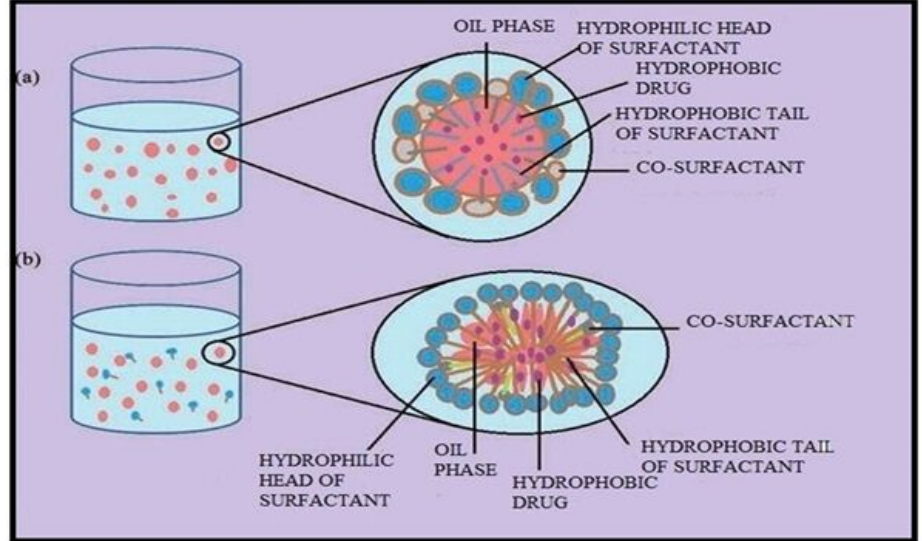
Figure 3. Schematic diagram showing the structures of ( a ) Nanoemulsion droplet and ( b ) Microemulsion droplet. Both are made up of surfactant, co-surfactant, and oil. Nanoemulsion droplets are spherical and show polydispersity in their size ( a ) whereas microemulsion droplets can be of a shape that is not necessarily spherical, and all droplets are of same diameter and shape ( b ). Reproduced with the consent of authors. Adapted from [2].